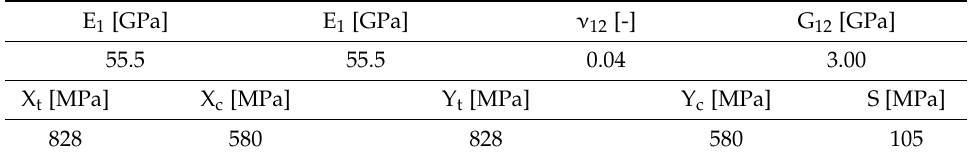
Table 2. Elastic and strength properties for substrate.